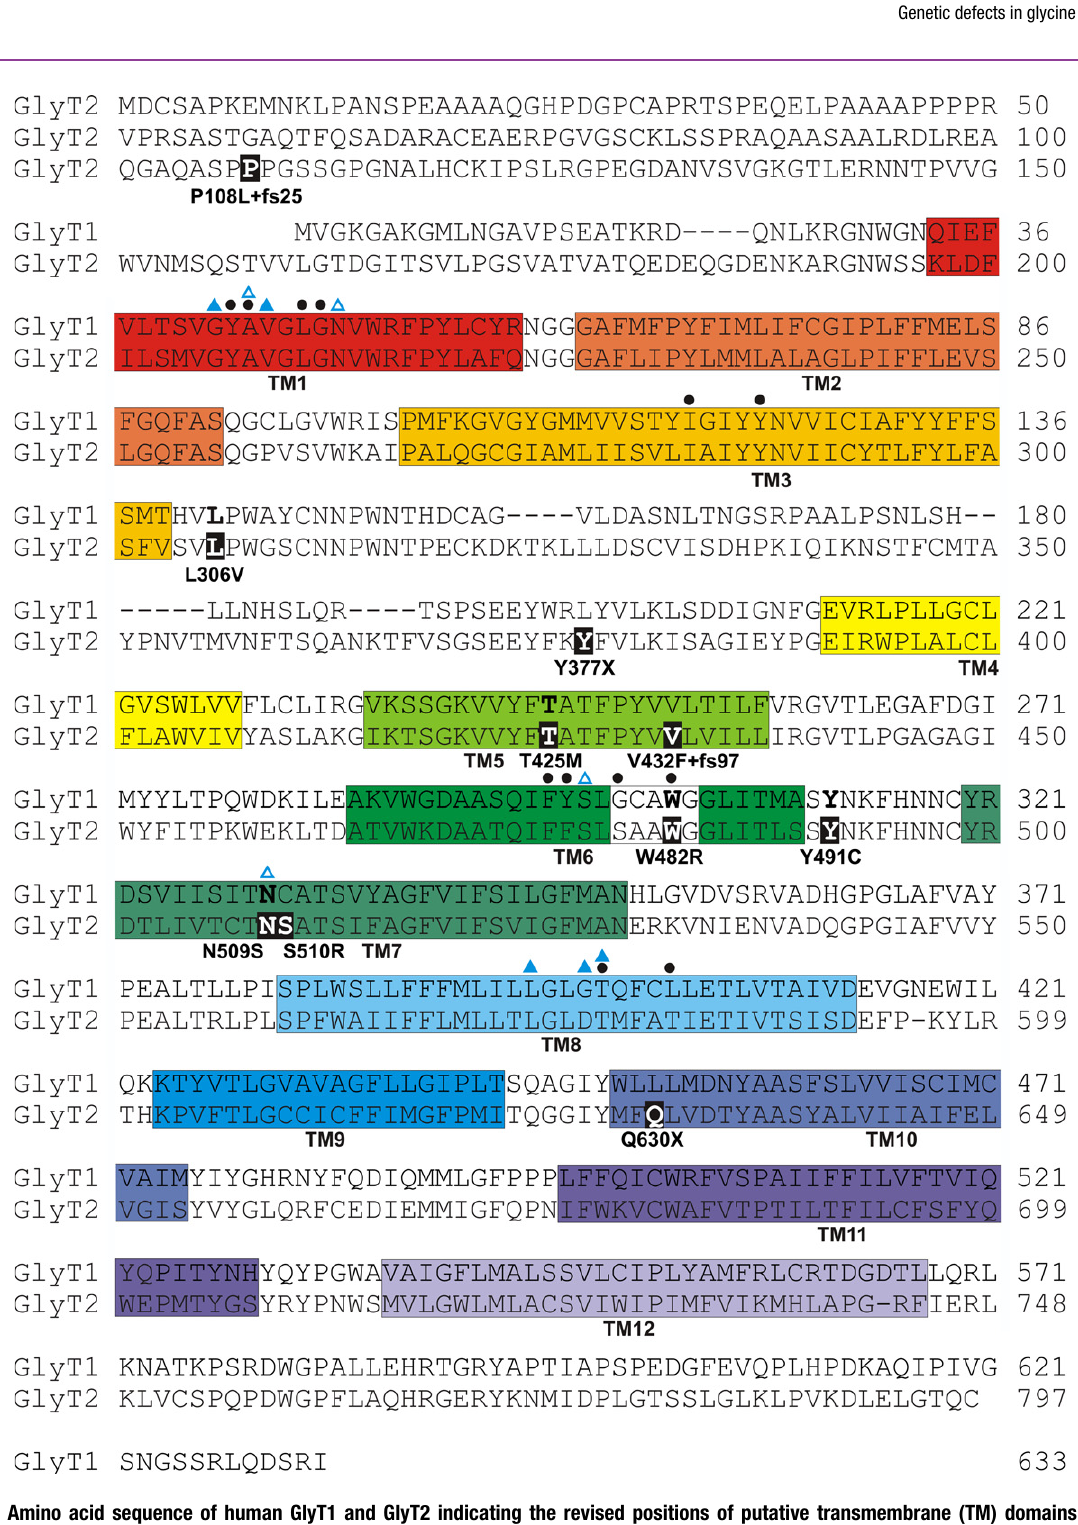
VIAAT has shown a severe phenotype (embryonic lethality, omphalocele and cleft palate) (Wojcik et al., 2006), it remains possible that missense mutations in VIAAT could lead to the loss of either GABA or glycine load- ing into synaptic vesicles. VIAAT was fi rst identifi ed (McIntire et al.,